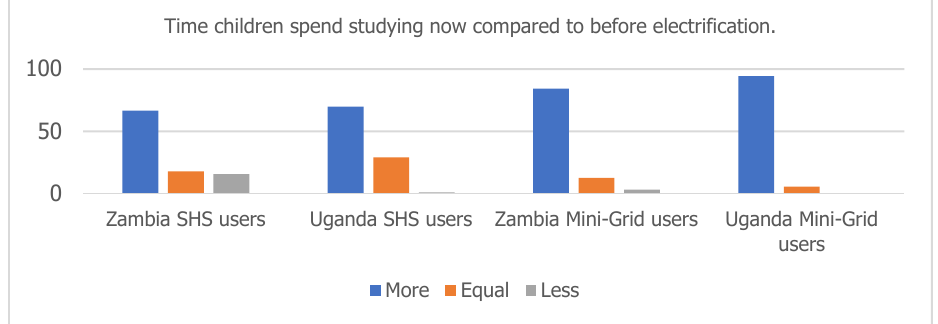
Figure A8. Impact of electrification on education among various subgroups; Responses in %.